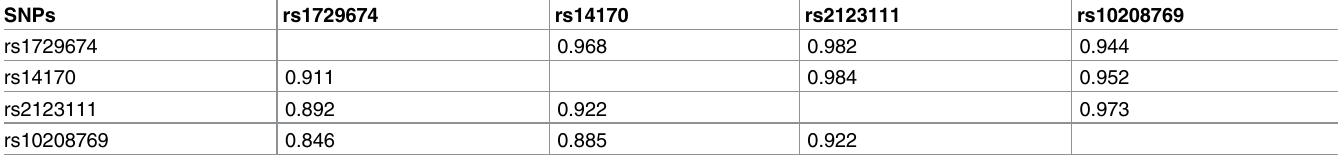
Table 3. Pairwise linkage disequilibrium (LD) results among SNPs rs1729674, rs14170,rs2123111 and rs10208769. SNPs